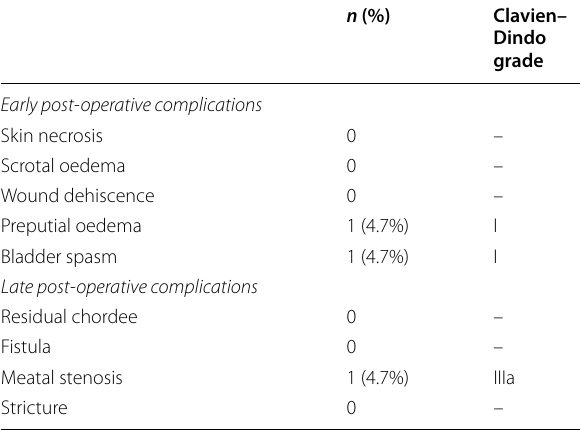
tubularised incised plate uretheroplasty